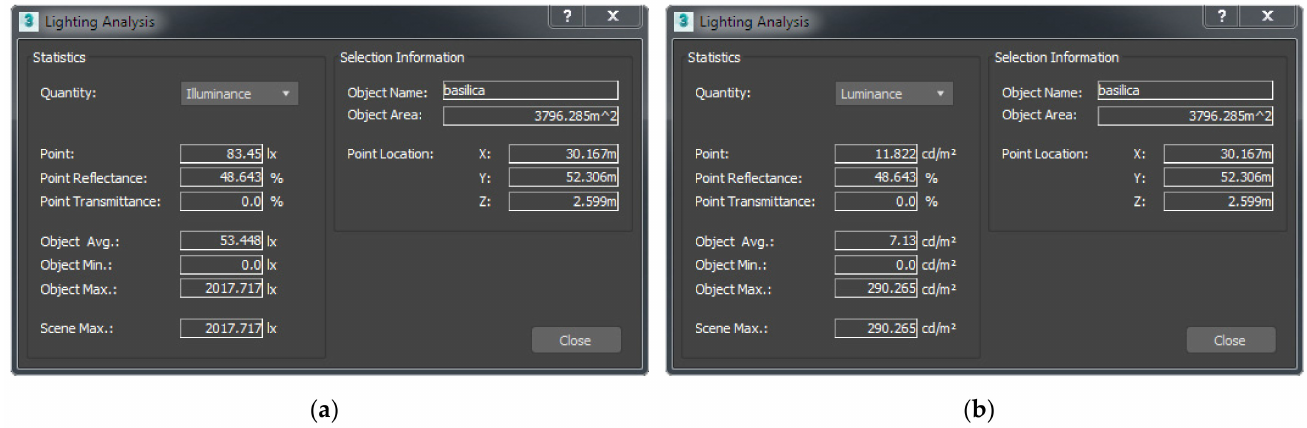
Figure 18. Lighting Analysis tool showing: ( a ) illuminance measurement and ( b ) luminance measurement and surface area measurement for the floodlighting design provided by Autodesk 3ds Max